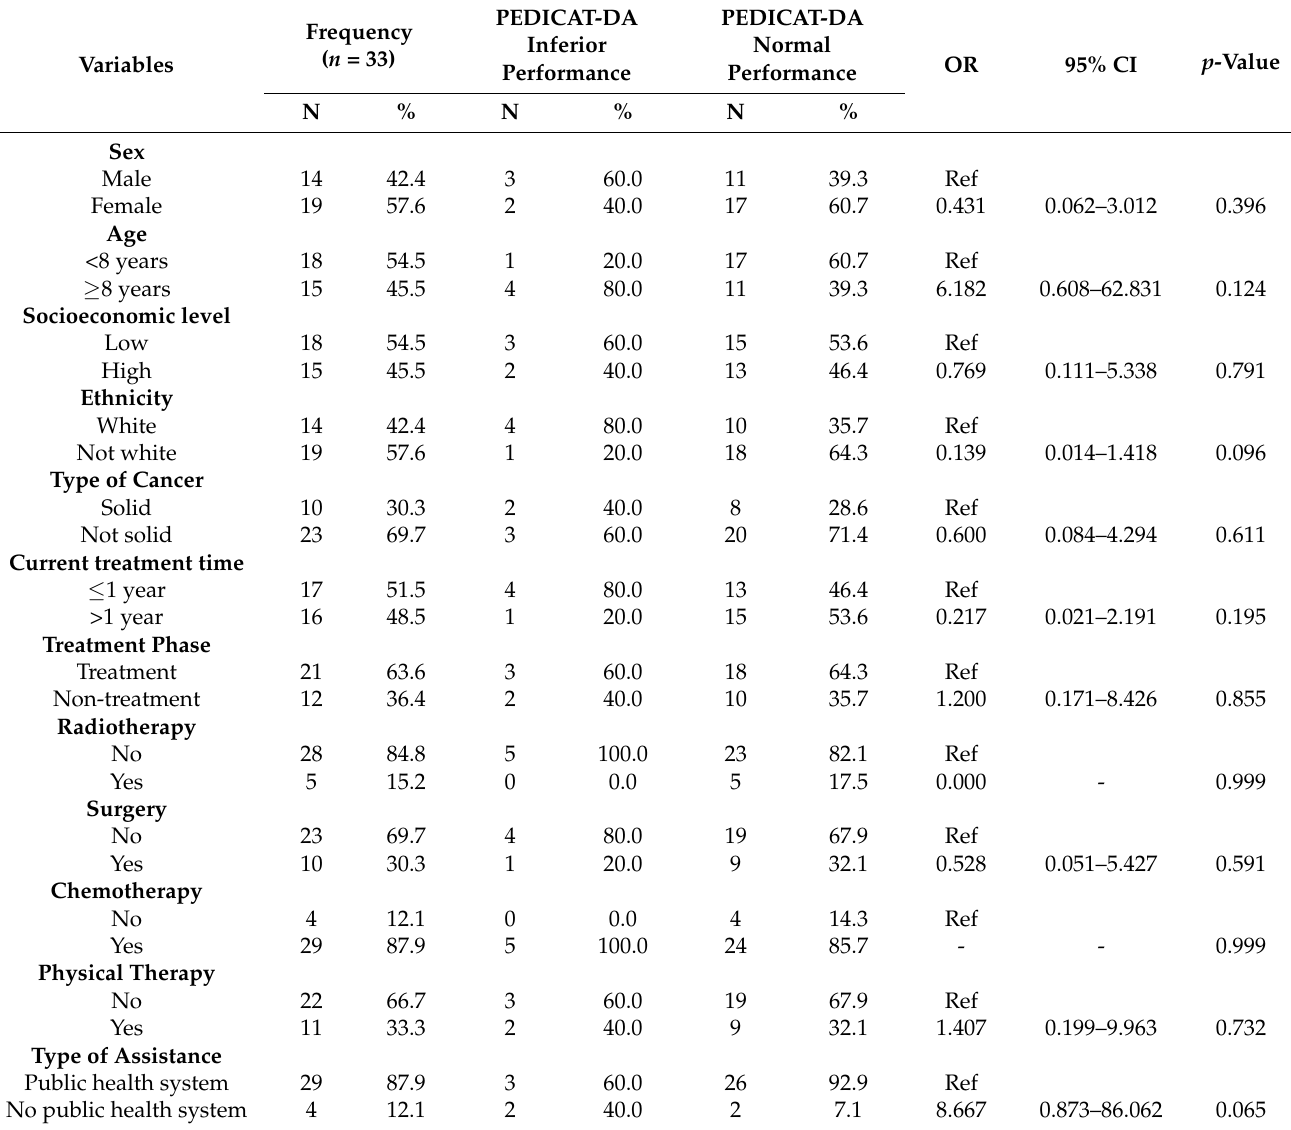
Table 1. Frequency, number of children with inferior and normal performance in PEDICAT-Daily Activities, odds ratio, 95% confidence interval, and p